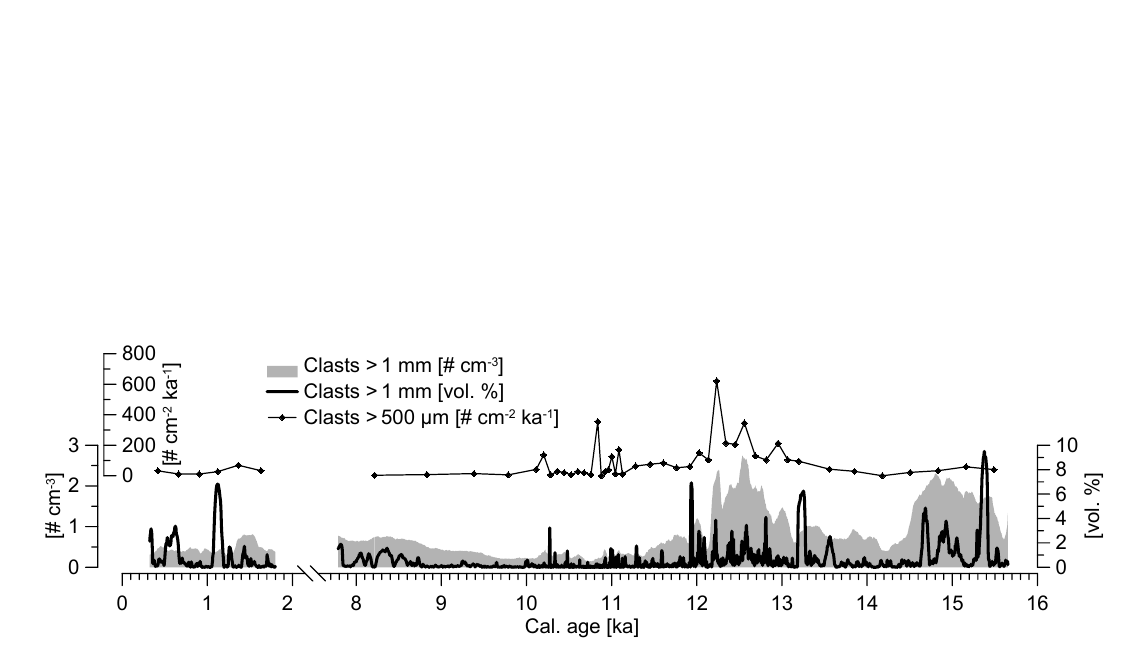
Figure A2. (a) Grain size distribution of fine siliciclastic sediments (0–63µm). (b) Interpreted CT analysis showing bioturbation (green) and clasts (orange). (c) X-ray density (black line) in Hounsfield units (HU) with standard deviation (red line) derived from CT analysis. Yellow rectangle marks disturbed section. Note coarsening upwards of fine sediments (a) , high accumulation of clasts (b) and increased X-ray density, as well as respective standard deviation (c) in the disturbed section.